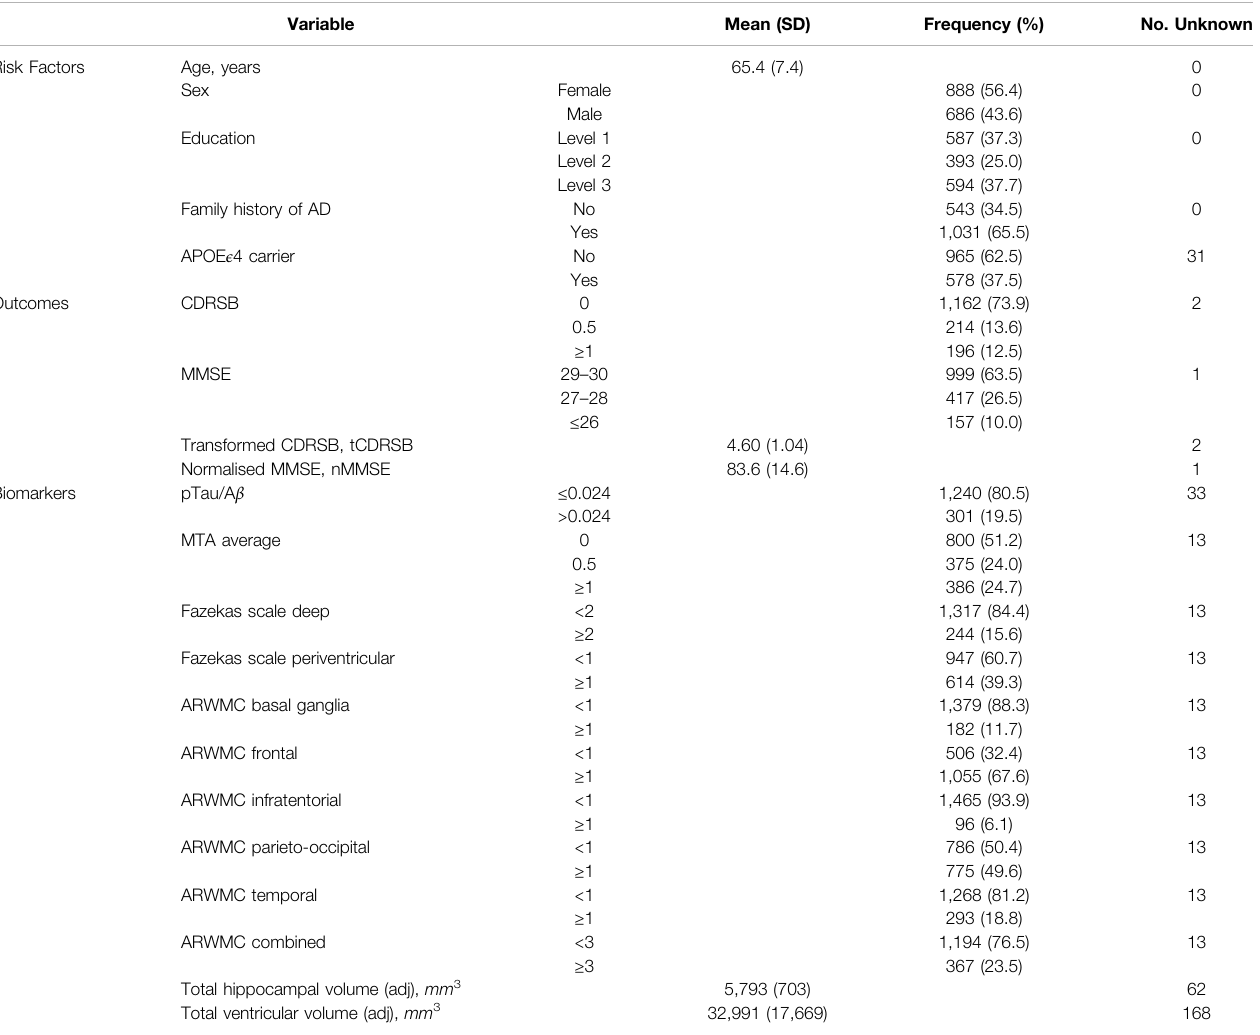
TABLE 1 | Baseline characteristics of the 1,574 participants with more than one